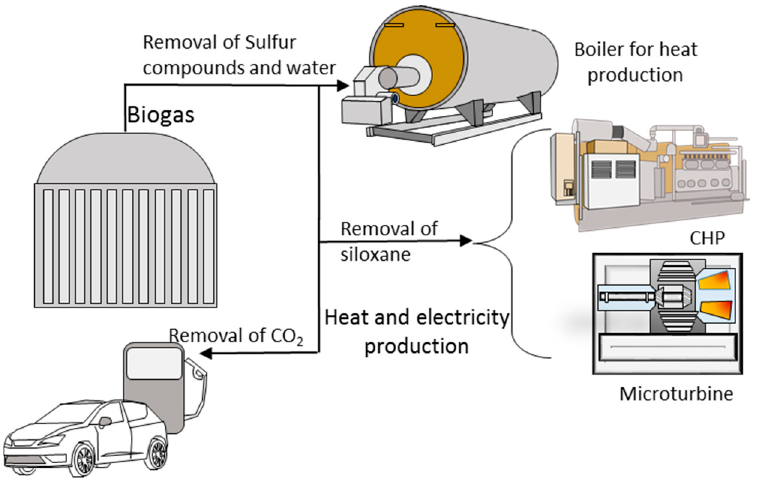
Figure 2. Different technologies for biogas valorization: Heat and electricity production or upgrading to be used as biofuel or injected into the natural gas grid. Biogas comprises CH 4 and CO 2 and traces of some other species such as ammonia, sulfidic acid, and mercaptans. Oxygen and nitrogen may also be present [123,124].